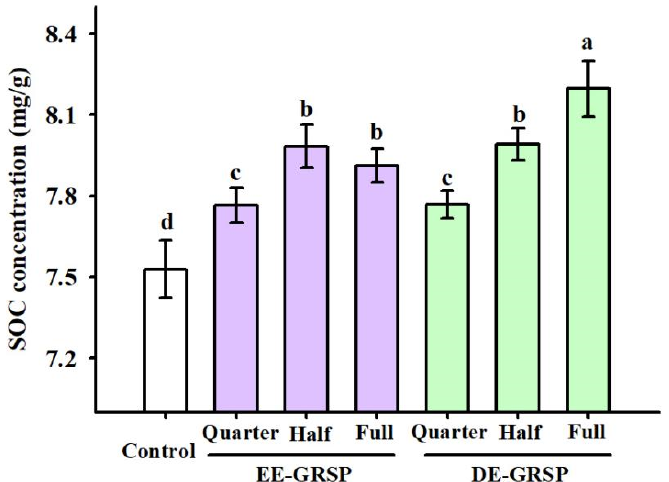
Figure 4. Correlation between the soil pH value and the soil MWD ( n = 28).